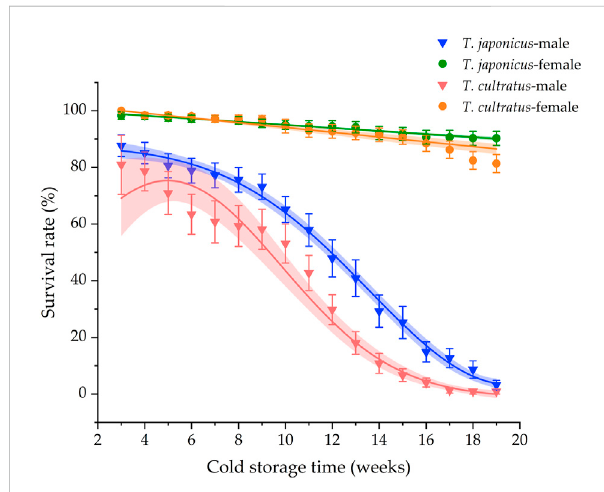
FIGURE 5 Survival rate of T. japonicus and T. cultratus during 19 weeks of cold storage at 11 ° C. Values are mean ± SE.